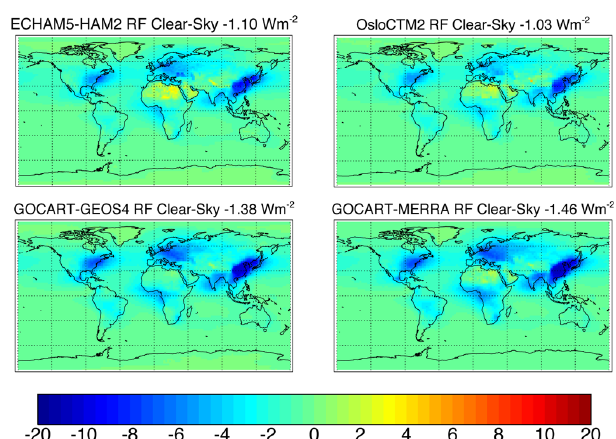
Fig. 21. Annual mean short-wave clear-sky top-of-atmosphere ra- diative forcing (RF) between present day and pre-industrial experi- ments with identical aerosol radiative properties based on an early release of Kinne et al. (2013).